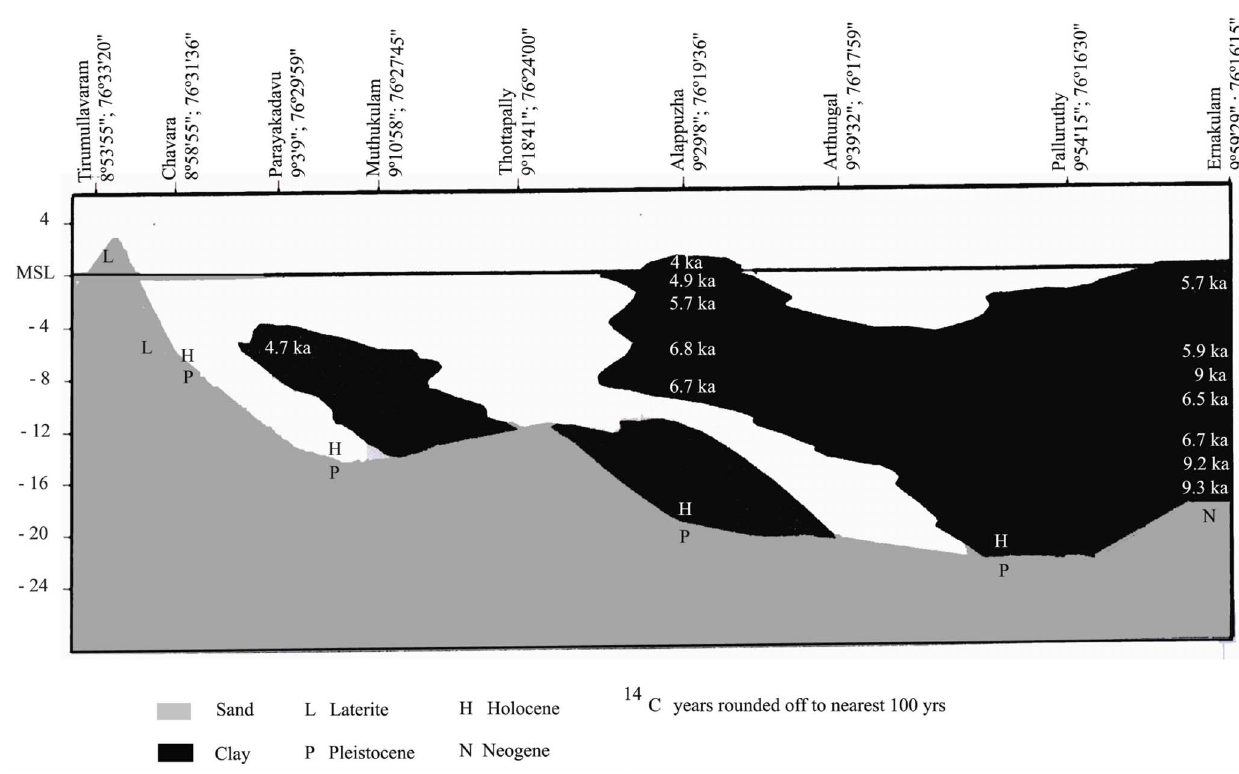
Figure 5. Cross sectional view Pleistocene and Holocene sediments along Kollam - Ernakulam coast.